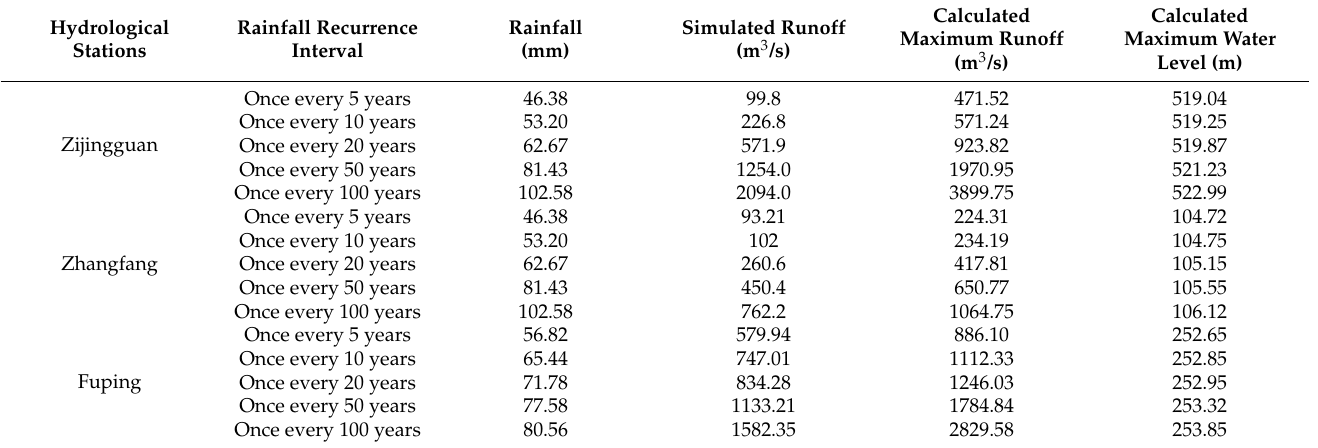
Table 4. Runoff and water-level-warning results of different rainfall recurrence intervals at each sta-